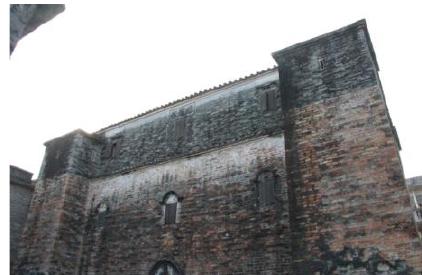
Figure 4. Yinglong Lou in Sanmenli village (source: field